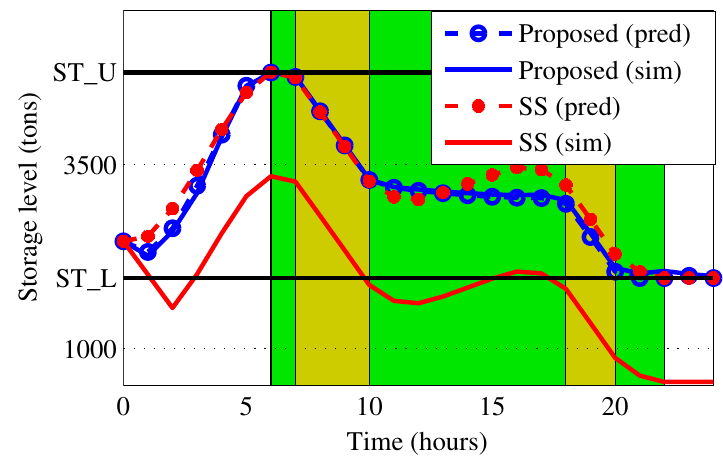
Figure 15. Predicted (pred) and flow model simulated (sim) storage level for both optimization solutions of Equations (23) and